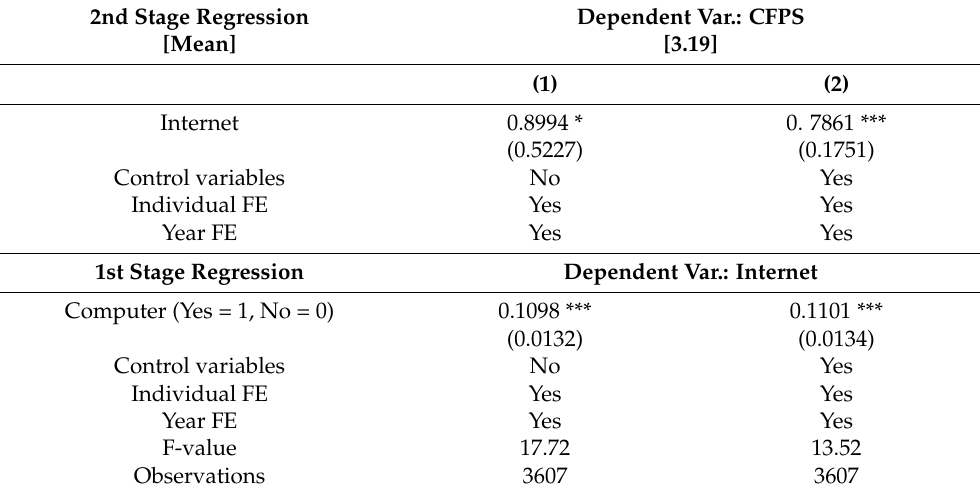
Table 7. Impact of Internet use on dietary quality of rural Chinese residents: results of 2SLS